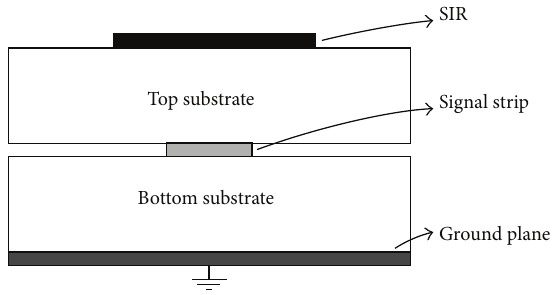
Figure 2: Cross-sectional view of a microstrip line loaded with an SIR, etched on top of